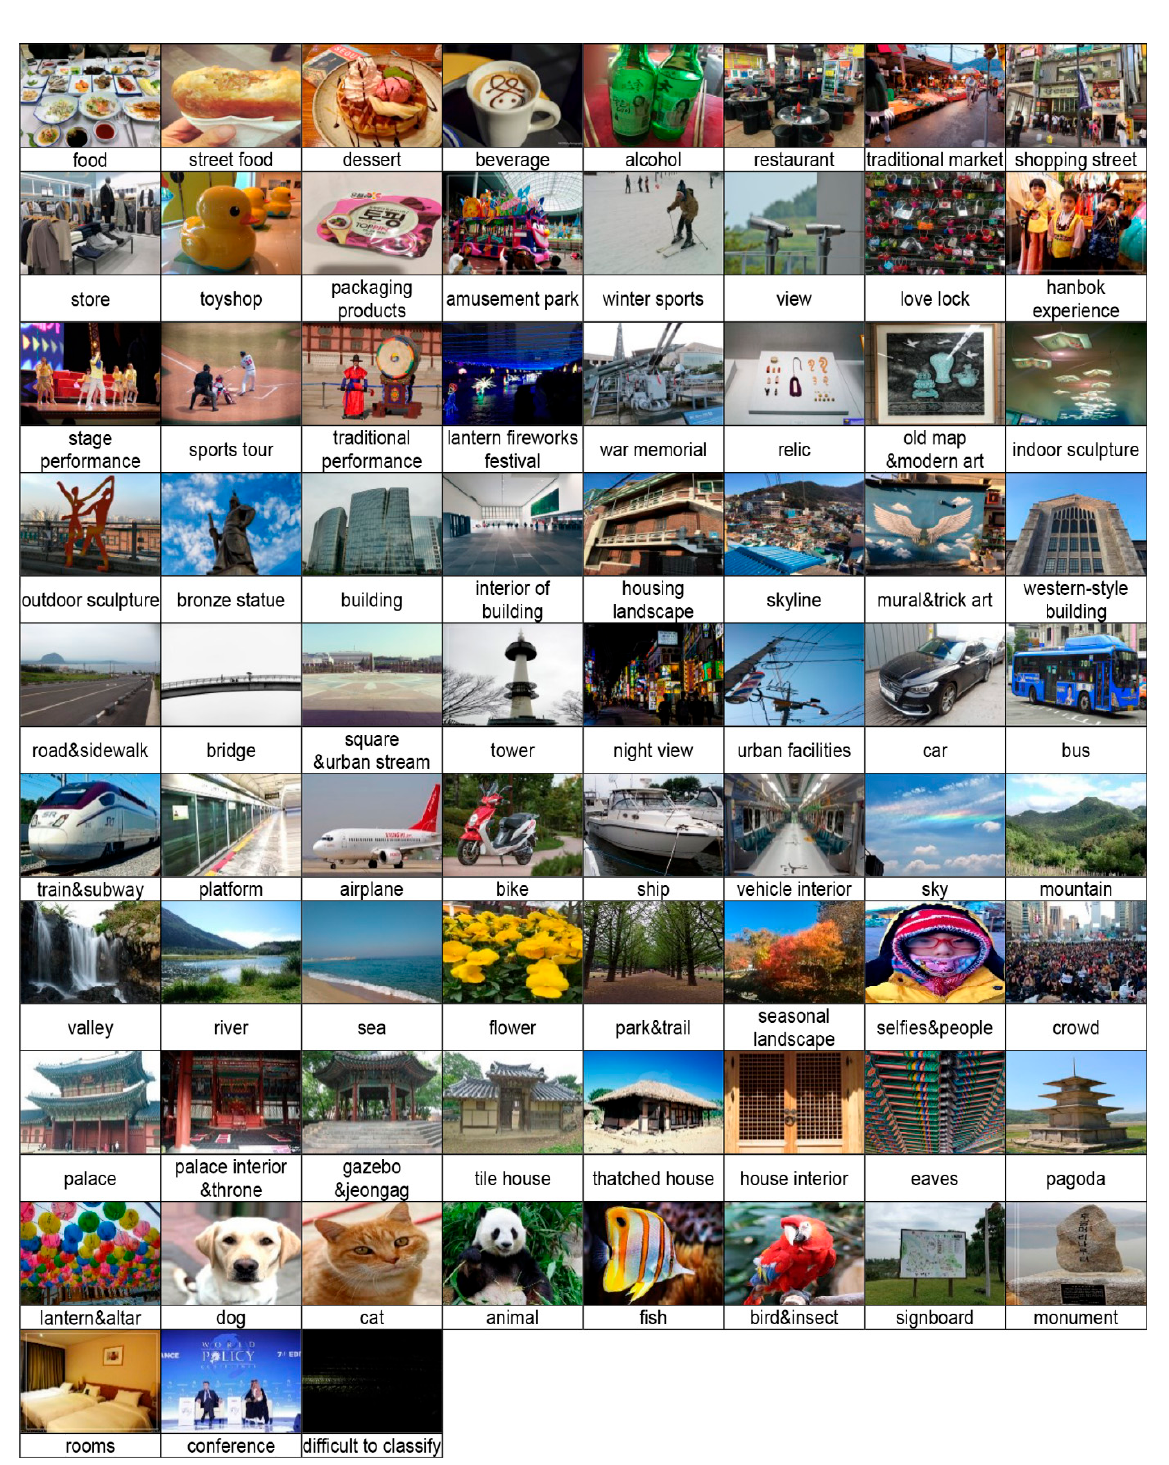
Figure 5. Example of representative photo for each scene.